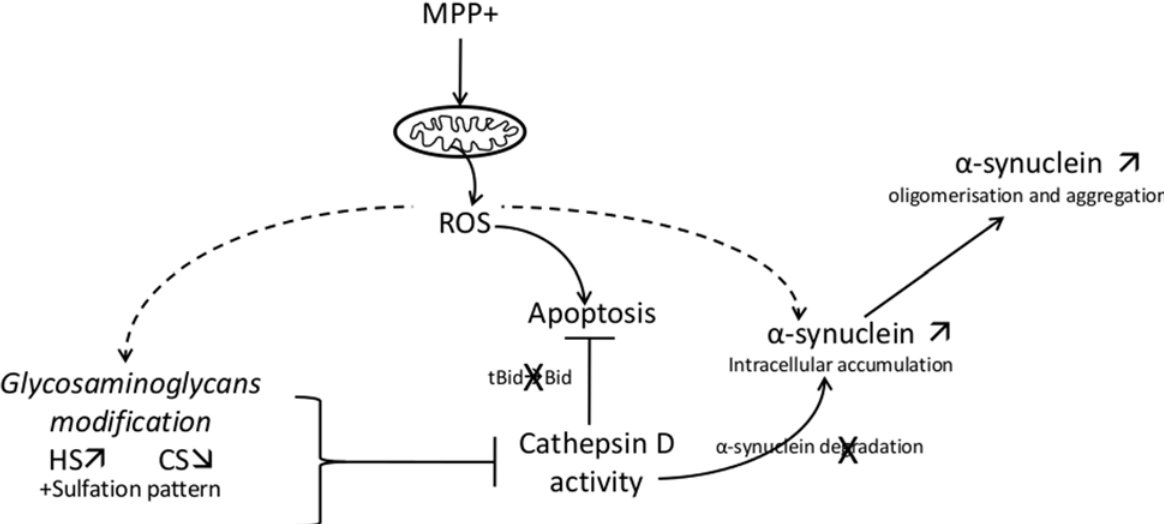
Figure 8. Interplay between CathD, glycosaminoglycans (heparan sulfate (HS), chondroitin sulfate (CS)) and α -synuclein on MPP + -stressed cells. See details in the